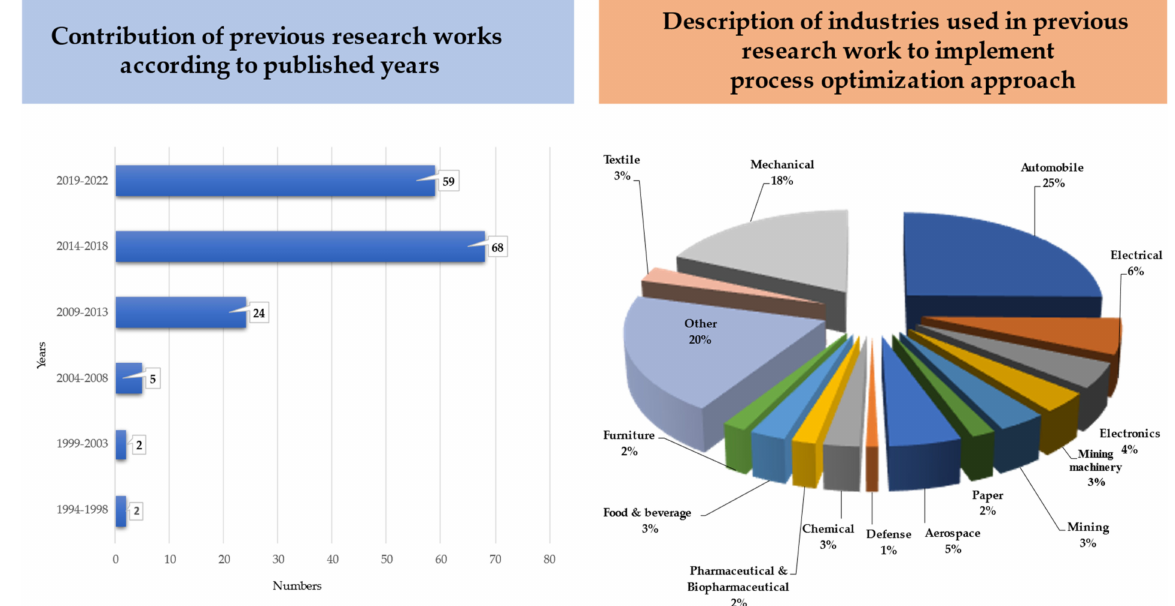
Figure 8. Analysis of the contribution of research works in different years and industries used in the previous